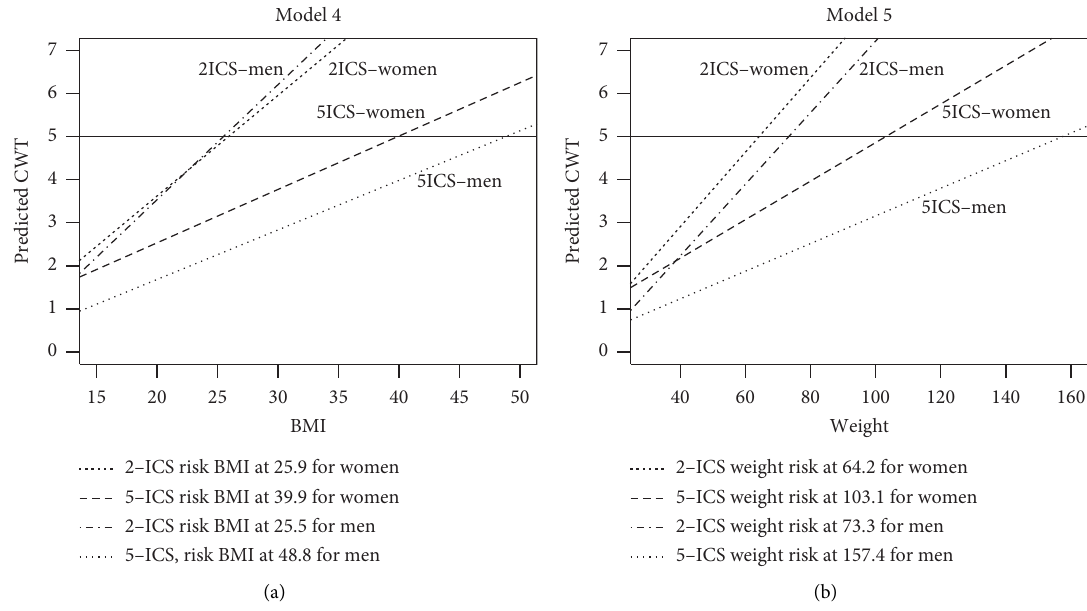
Figure 4: The estimation of CWT via Model 4 (left panel) and Model 5 (right panel). Women at 2nd ICS: dashed line; women at 5th ICS: long dash line; men at 2nd ICS: dotted line; men at 5th ICS: dotted